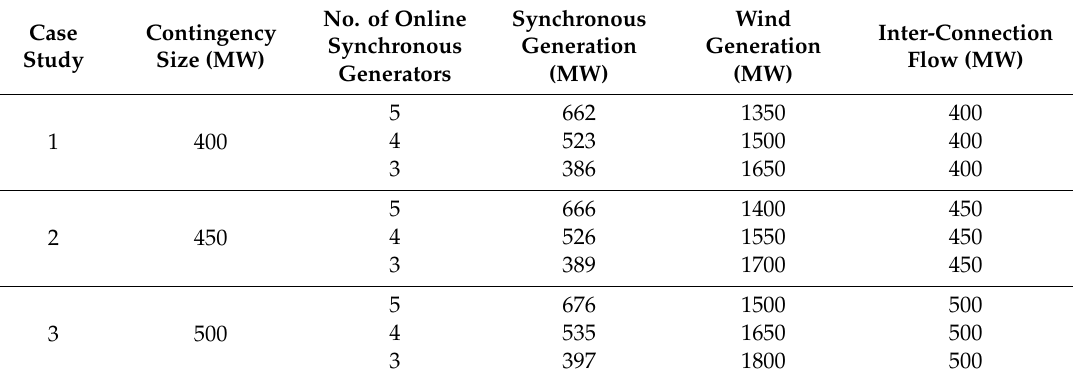
Table 2. Simulation